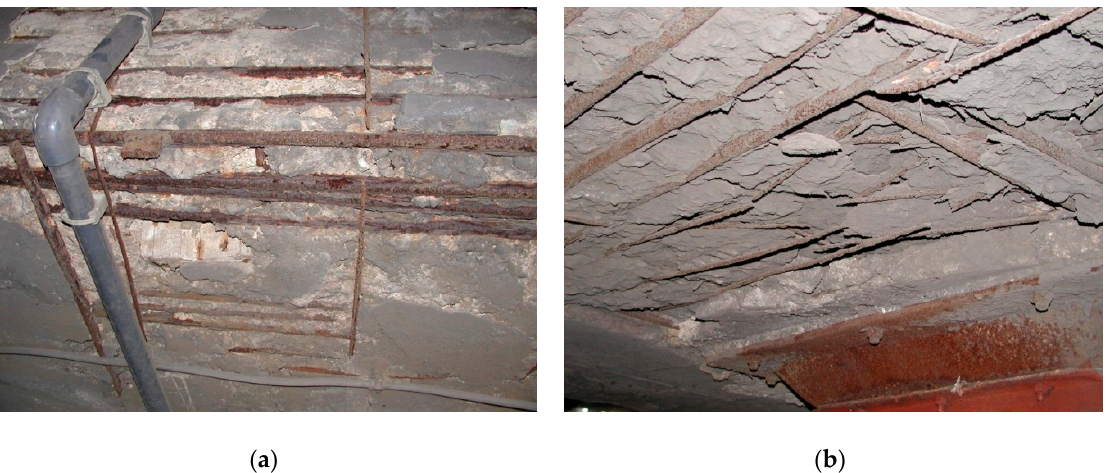
Figure 3. Examples of steel damage in one of the structure C: ( a ) corrosion of steel rebars with concrete damage, ( b ) locally interrupted reinforcement.